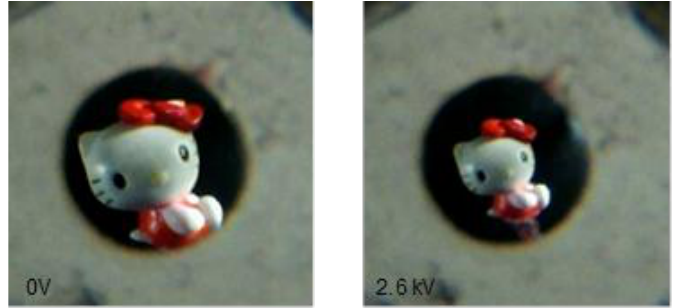
Figure 4. Images of the object observed through the liquid lens at different voltages. The figures are adapted from Ref. [47] with permission.